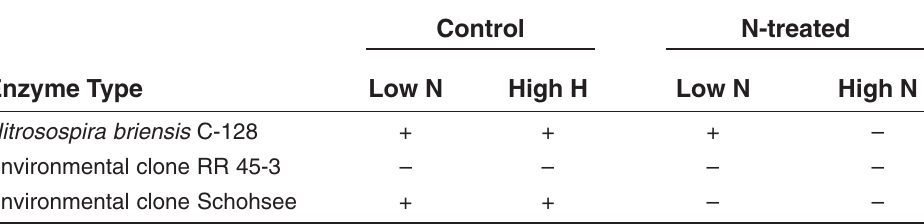
Presence of Ammonia Monooxygenase Enzyme Types in Low N Processing and High N Processing Plots Within Control and N-treated Watersheds of Fernow Experimental Forest, West